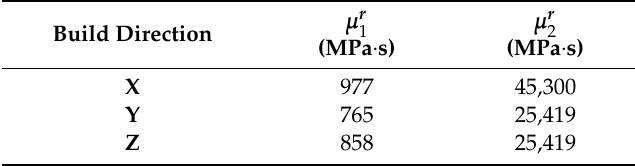
and µ r for the di ff erent types of specimen. 2 1